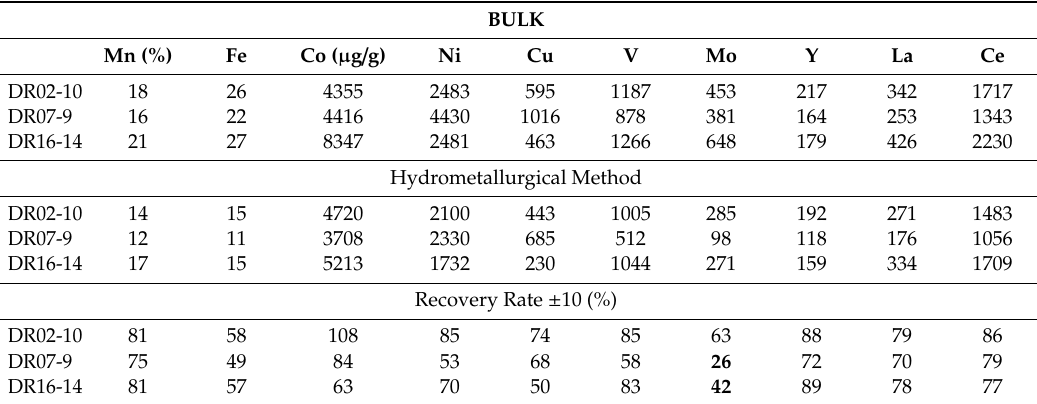
Table 6. Recovery rate of the most valuable metals of the studied samples. Values marked in bold refer to too high or too low values